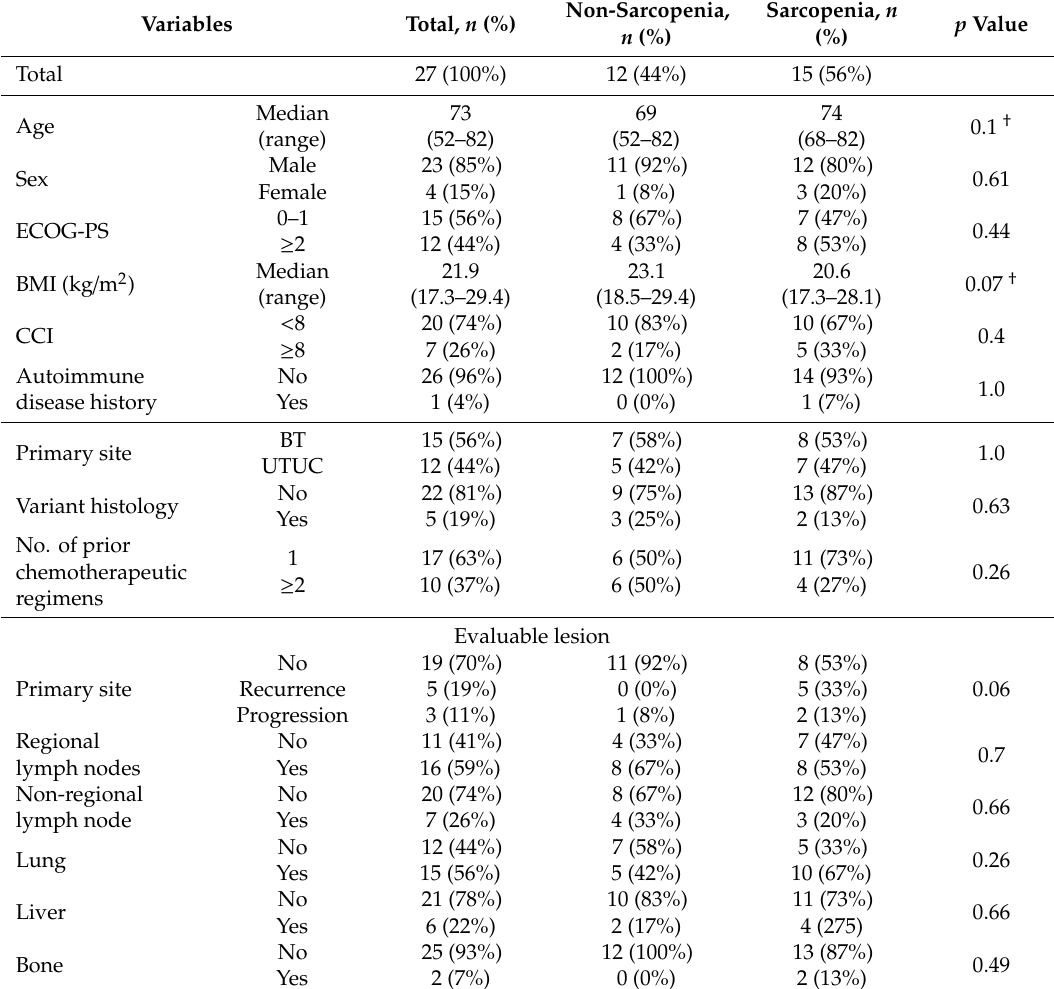
Table 1. Clinicopathological information on the first administration of